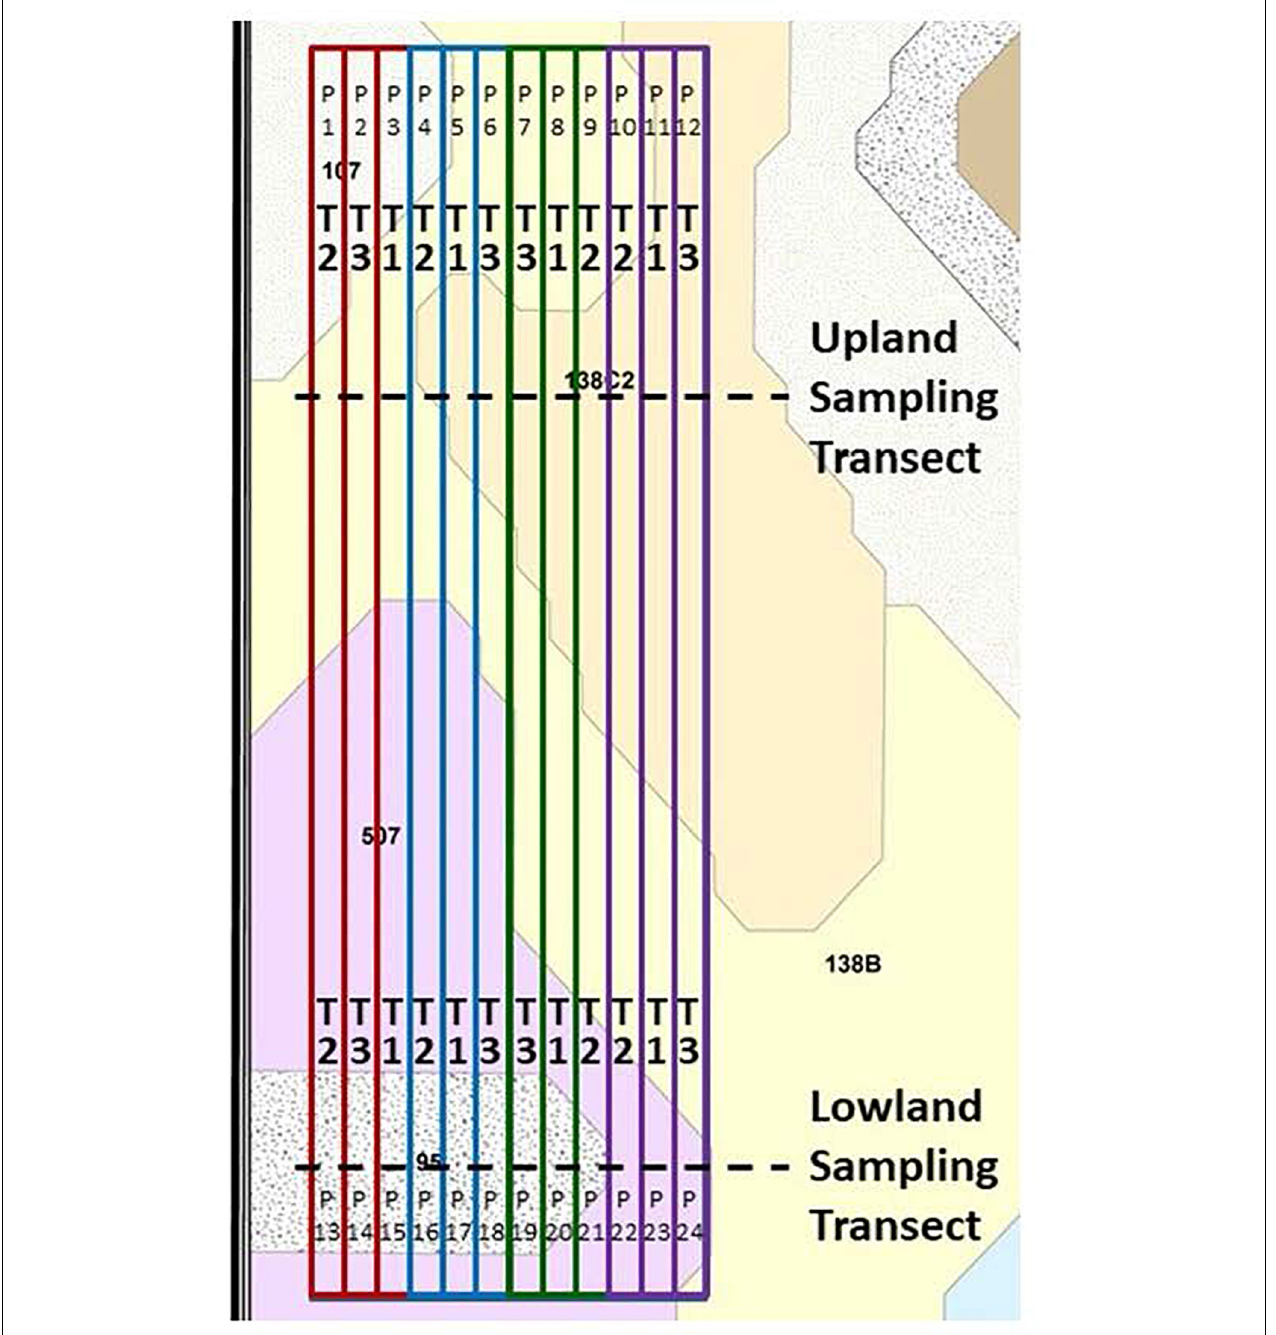
FIGURE 3 | Field design of the Kelley on-farm field research site location, shown with soil mapping units and boundaries of the field-long treatment strips. The treatments are explained in the caption of Figure 2 and the main text. Plot numbers are shown as “P.” Key to soil mapping units: 95, Harps loam, 1 to 3% slopes; 138B, Clarion loam, 2 to 5% slopes; 138C2, Clarion loam, 5 to 9% slopes, moderately eroded; and 507, Canisteo silty clay loam, 0 to 2%